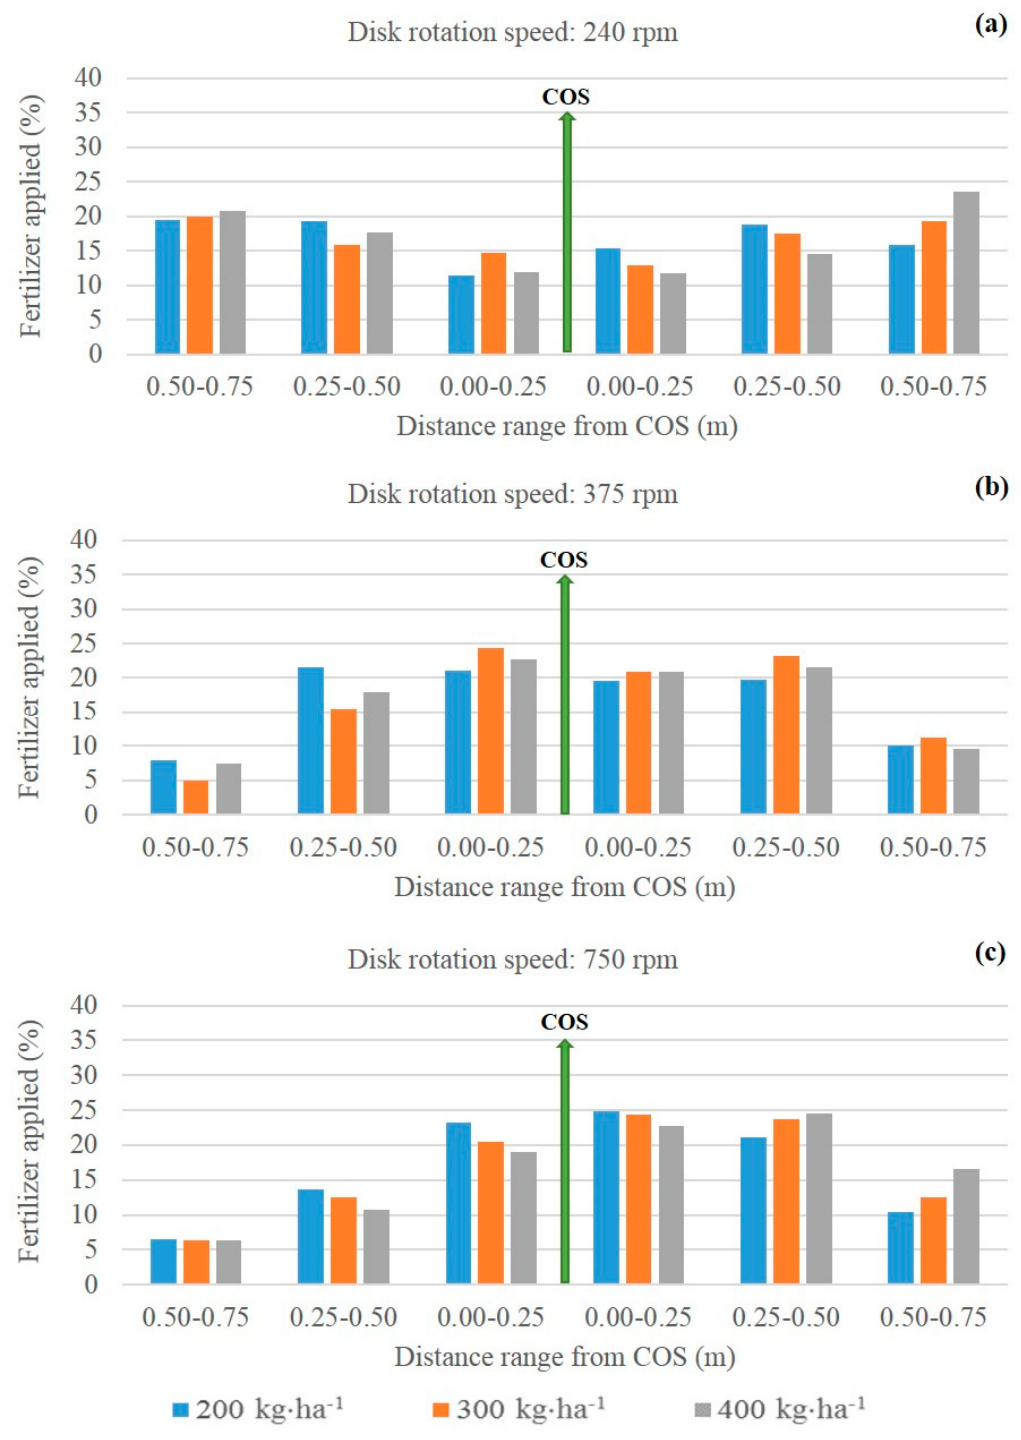
Figure 5. Transverse distribution profile histograms showing the percentage of fertilizer applied to different distance ranges from the coffee plant’s orthotropic stem (COS) for application on both sides of the coffee plants (FA2) at three fertilizer doses and three spreading disk rotation speeds: ( a ) 240 rpm; ( b ) 375 rpm; ( c ) 750 rpm.